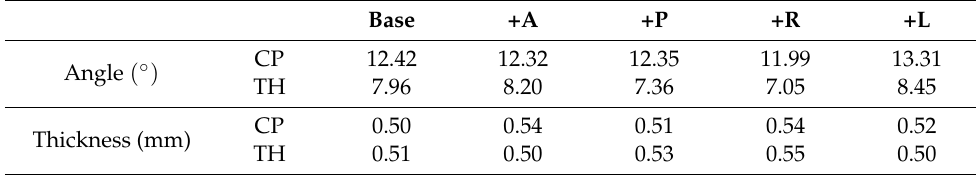
Table 2. Angle and skull thickness as functions of transducer